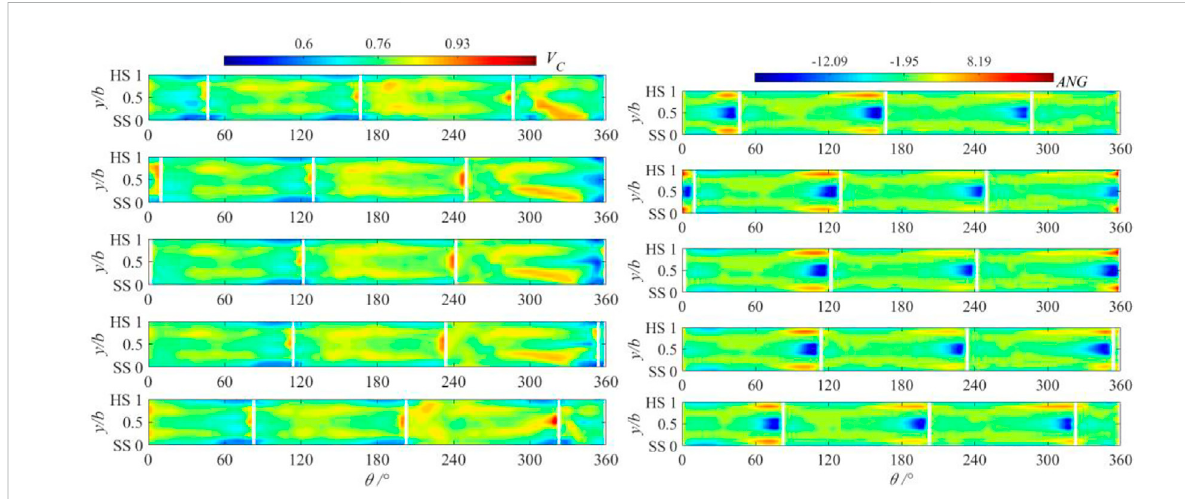
Distribution of circumferential velocity and fl ow angle in the volute outlet at BEP.